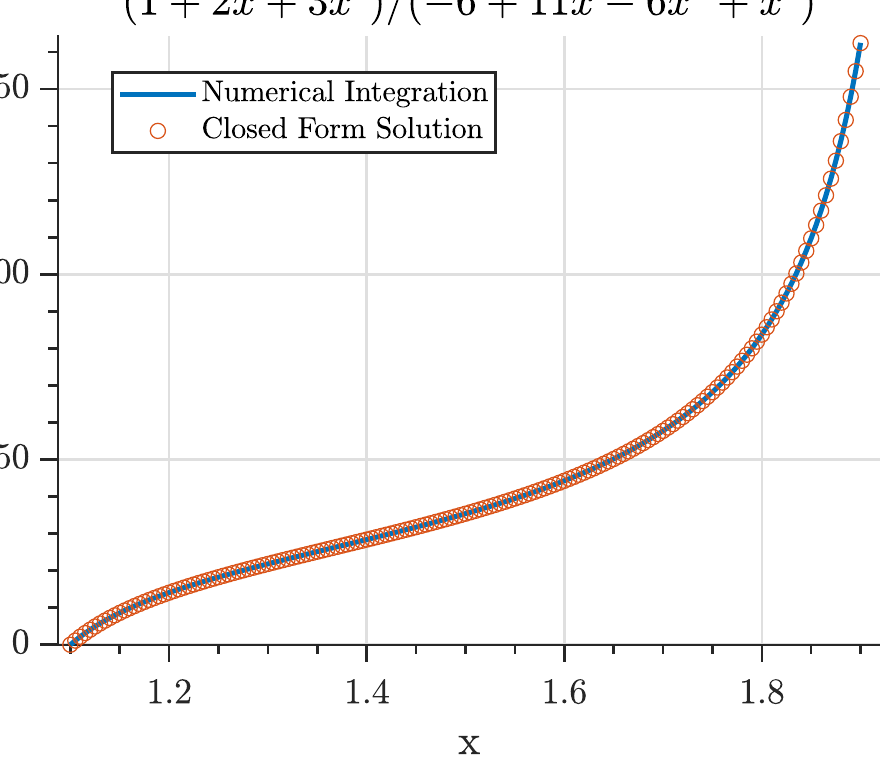
Figure 2. Agreement between the closed-form solution shown in Equation (23), and the numerical integration of the polynomial ratio given in the plot